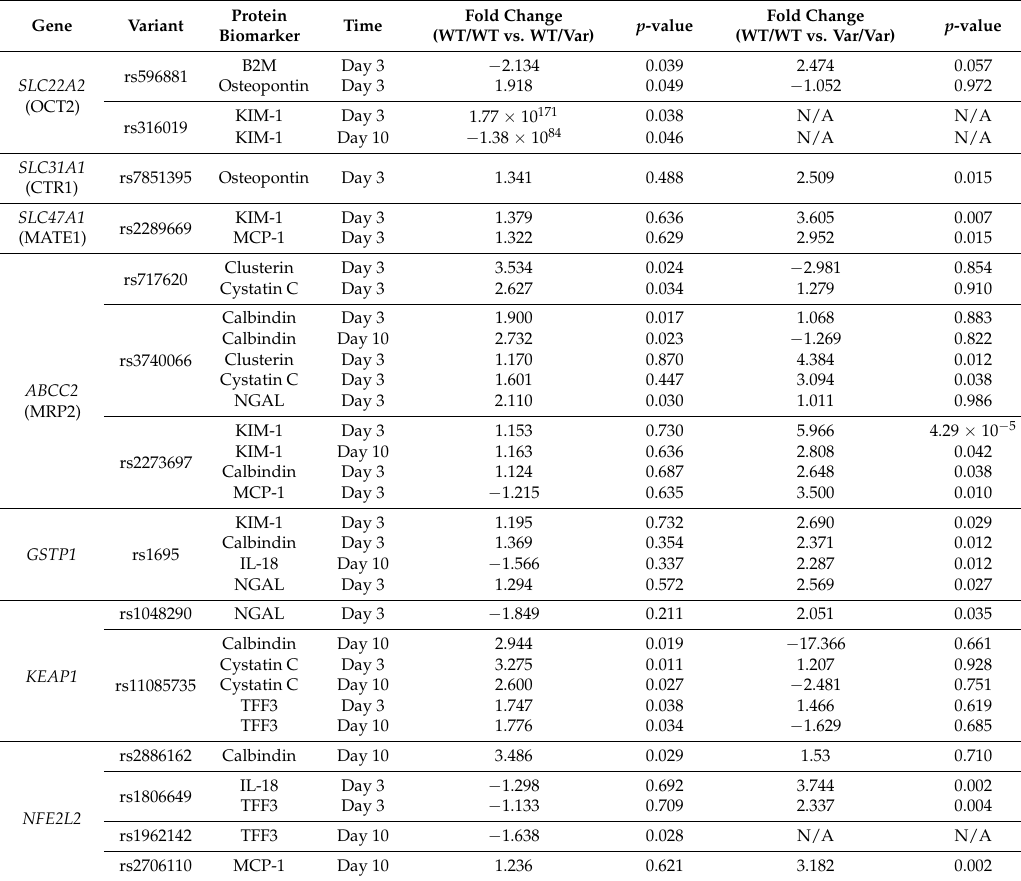
Table 3. Associations between Variant Genotypes and Fold Change Increases in Urinary Biomarkers of Kidney Injury ( n = 57)